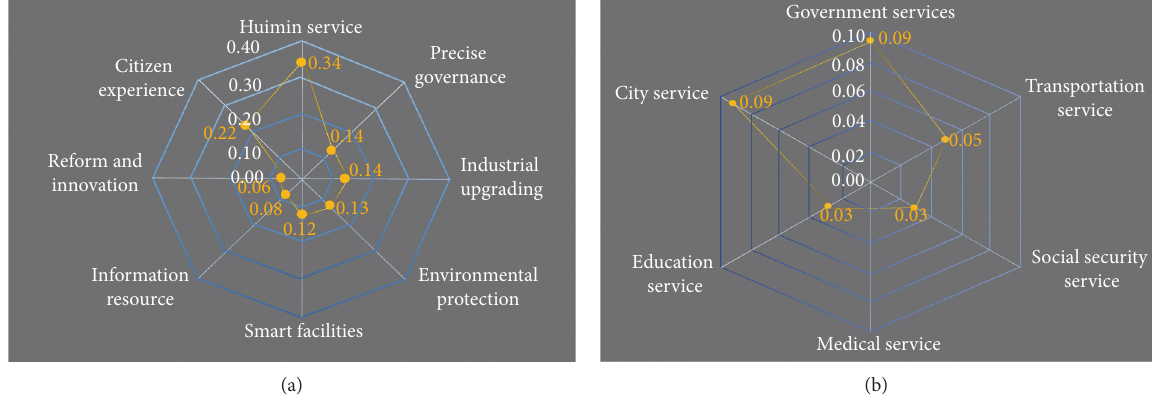
Figure 5: Radar chart of index combination weight in smart city.